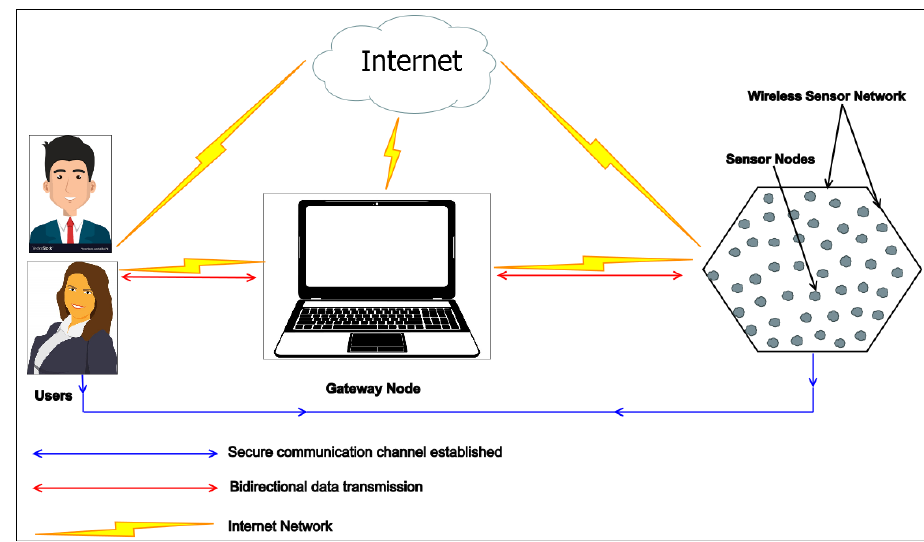
Figure 5. Sensors Enabled IoT Network.